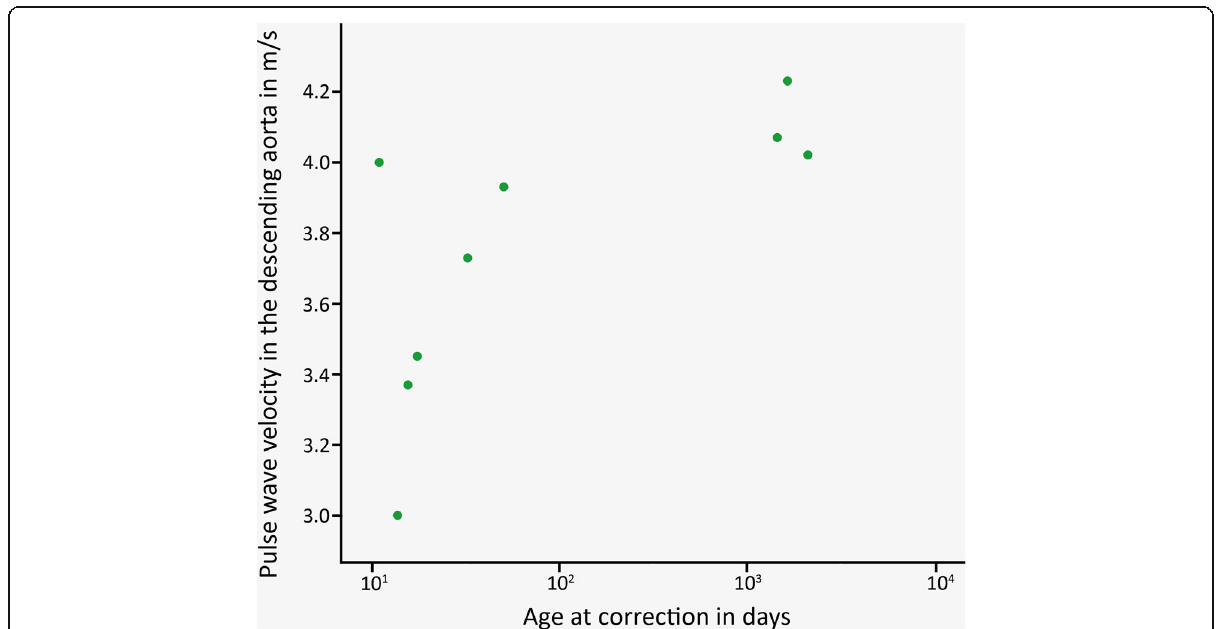
Fig. 2 Plot of the descending aorta pulse wave velocity over the age at correction for the tricuspid aortic valve patient